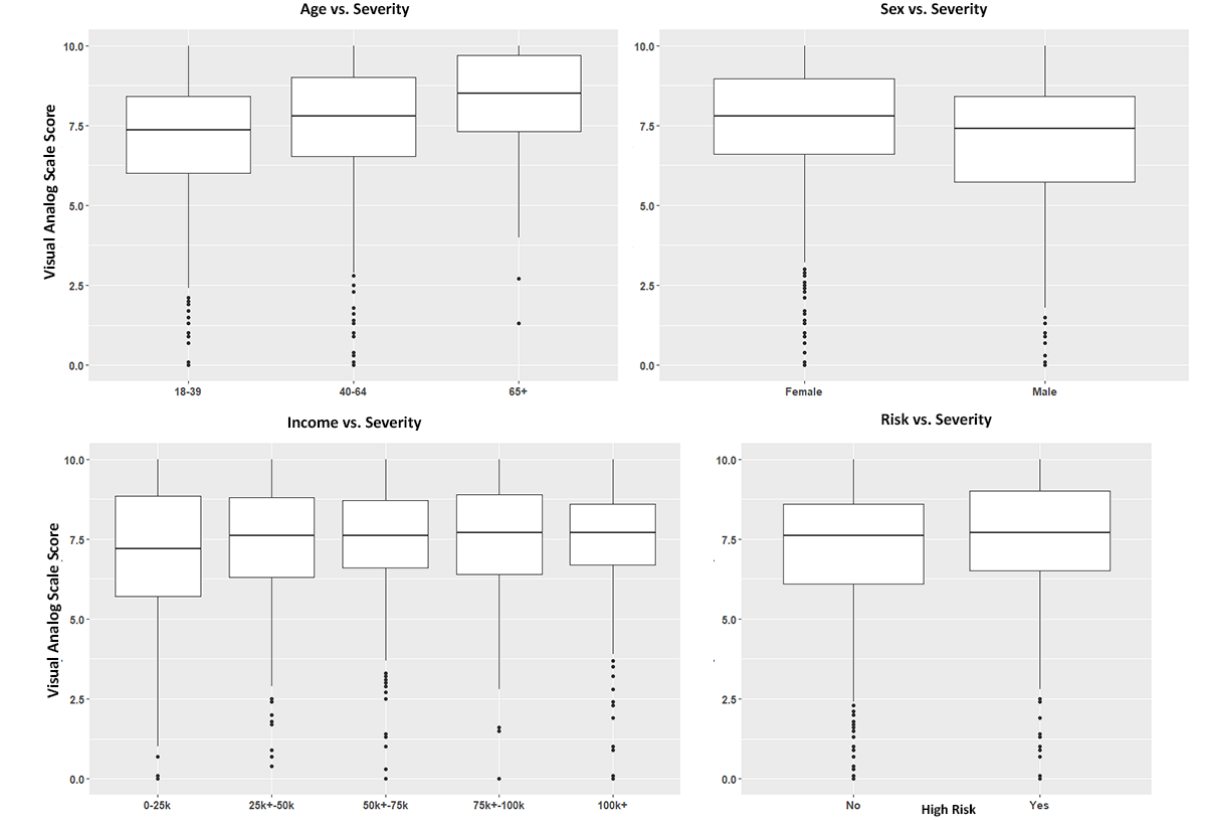
Figure 5. Box and whisker plots depicting the distribution and median of visual analog scale scores of study participants in response to their perception of the severity of the COVID-19 pandemic, with respect to age cohort, sex, income level, and health risk status, with high-risk individuals defined within the